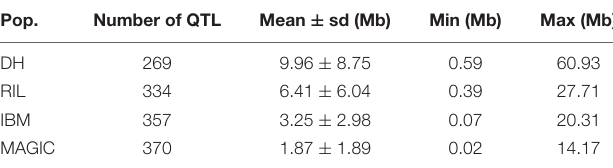
TABLE 5 | Map resolution of different population